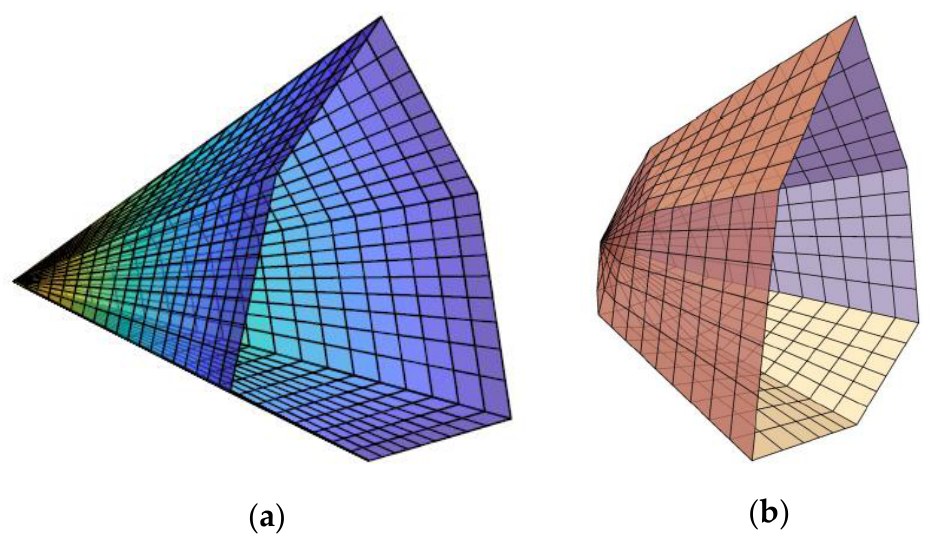
Figure 1. Intact M–C surface and the cut-off M–C surface. ( a ) intact M–C surface in the principal stress space; ( b ) the cut-off M–C surface in the principal stress space.